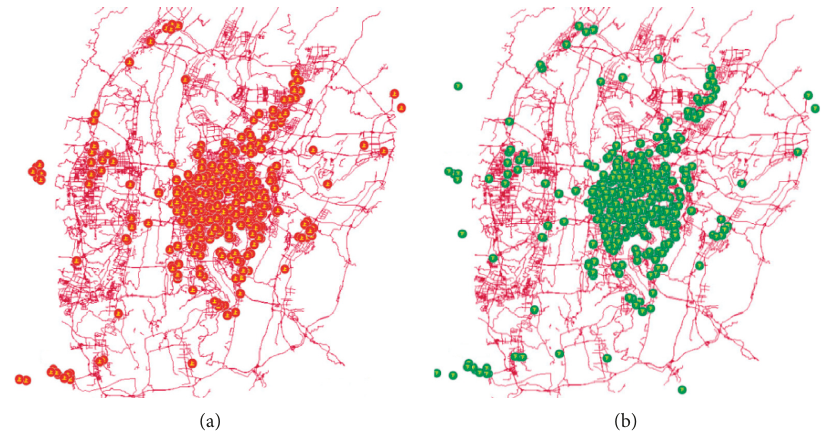
Figure 2: OD distribution of sampled residents in Chongqing. (a) Origin. (b) Destination.